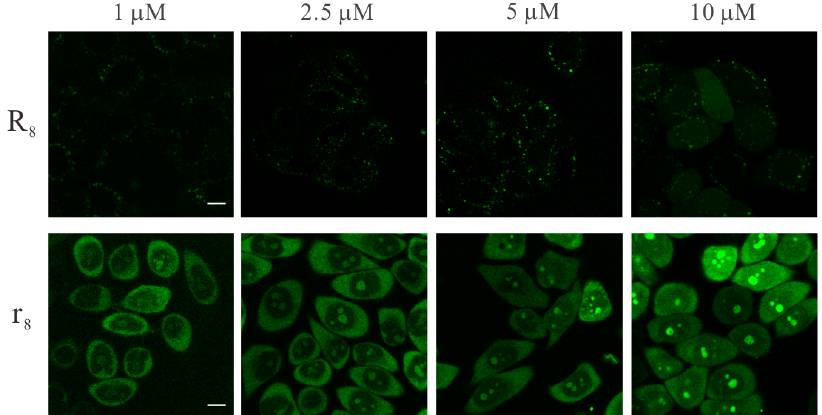
Fig. 1. Confocal microscopy images of living HeLa cells after incubation with the FITC-labeled peptides (various concentrations) at 37 (cid:2) C for 5 min in serum-free DMEM (300 (cid:1) L). Scale bar: 10 (cid:1)